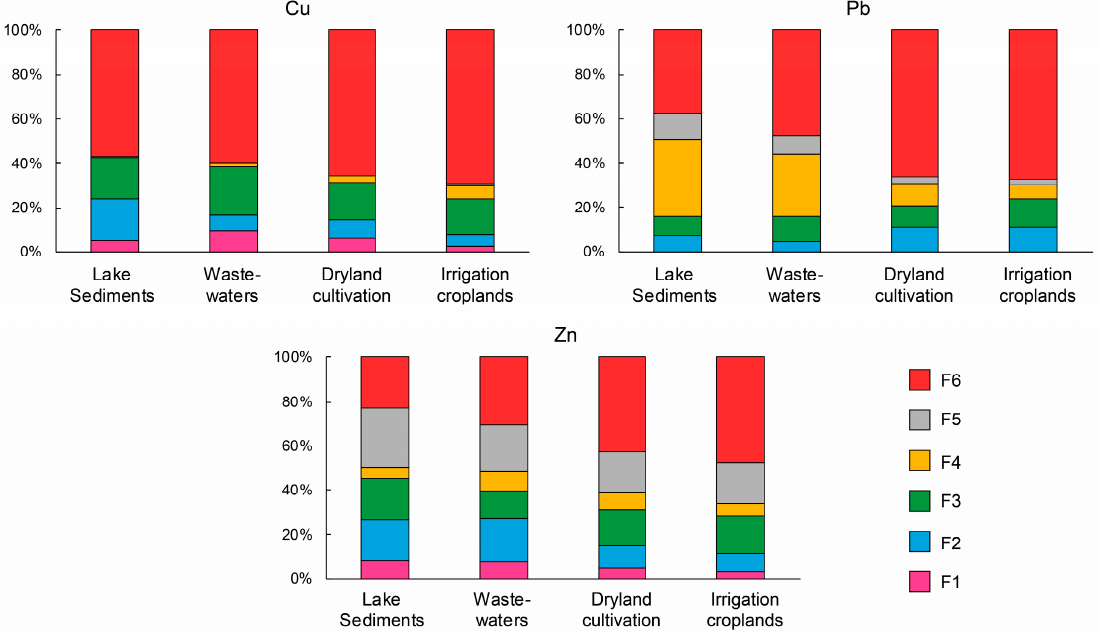
Figure 2. Distribution of Cu, Pb, and Zn in the different fractions for the studied sediment samples ( n = 14). F1: exchangeable fraction. F2: bound to carbonates. F3: bound to Mn oxides. F4: bound to organic matter. F5: bound to Fe oxides. F6: residual